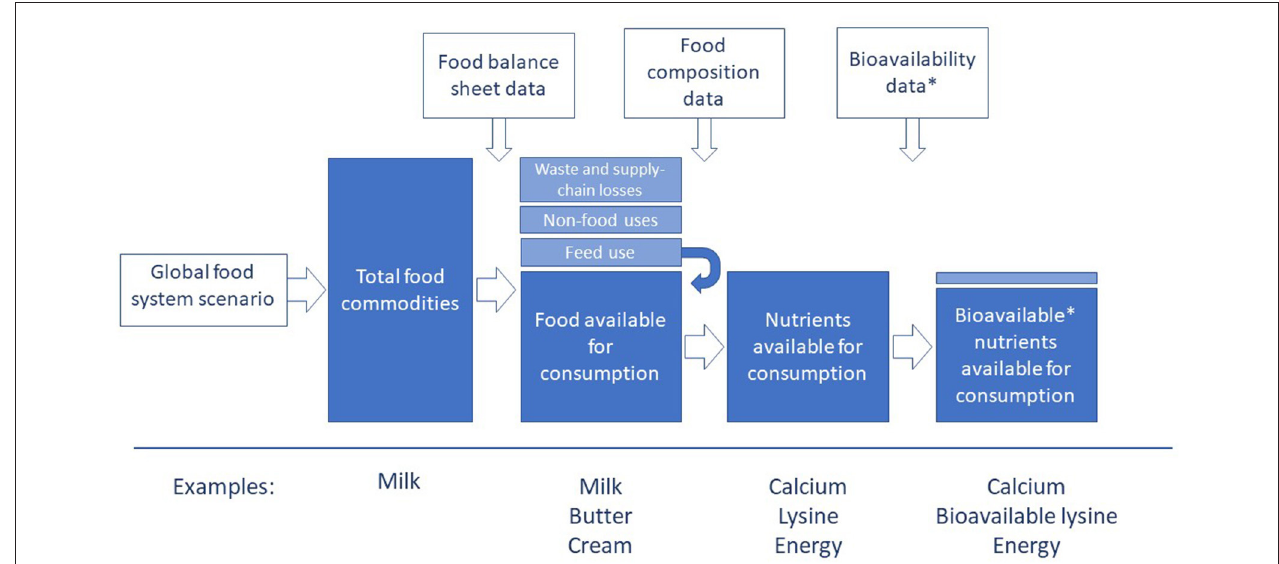
FIGURE 1 | Illustration of the DELTA Model calculation process used to generate the results. See Materials and Methods and Smith et al. (10) for more detailed description. Some examples of food commodities, foods, and nutrients are shown for each stage of the calculation. *Bioavailability coefficients are applied to protein and the indispensable amino acids